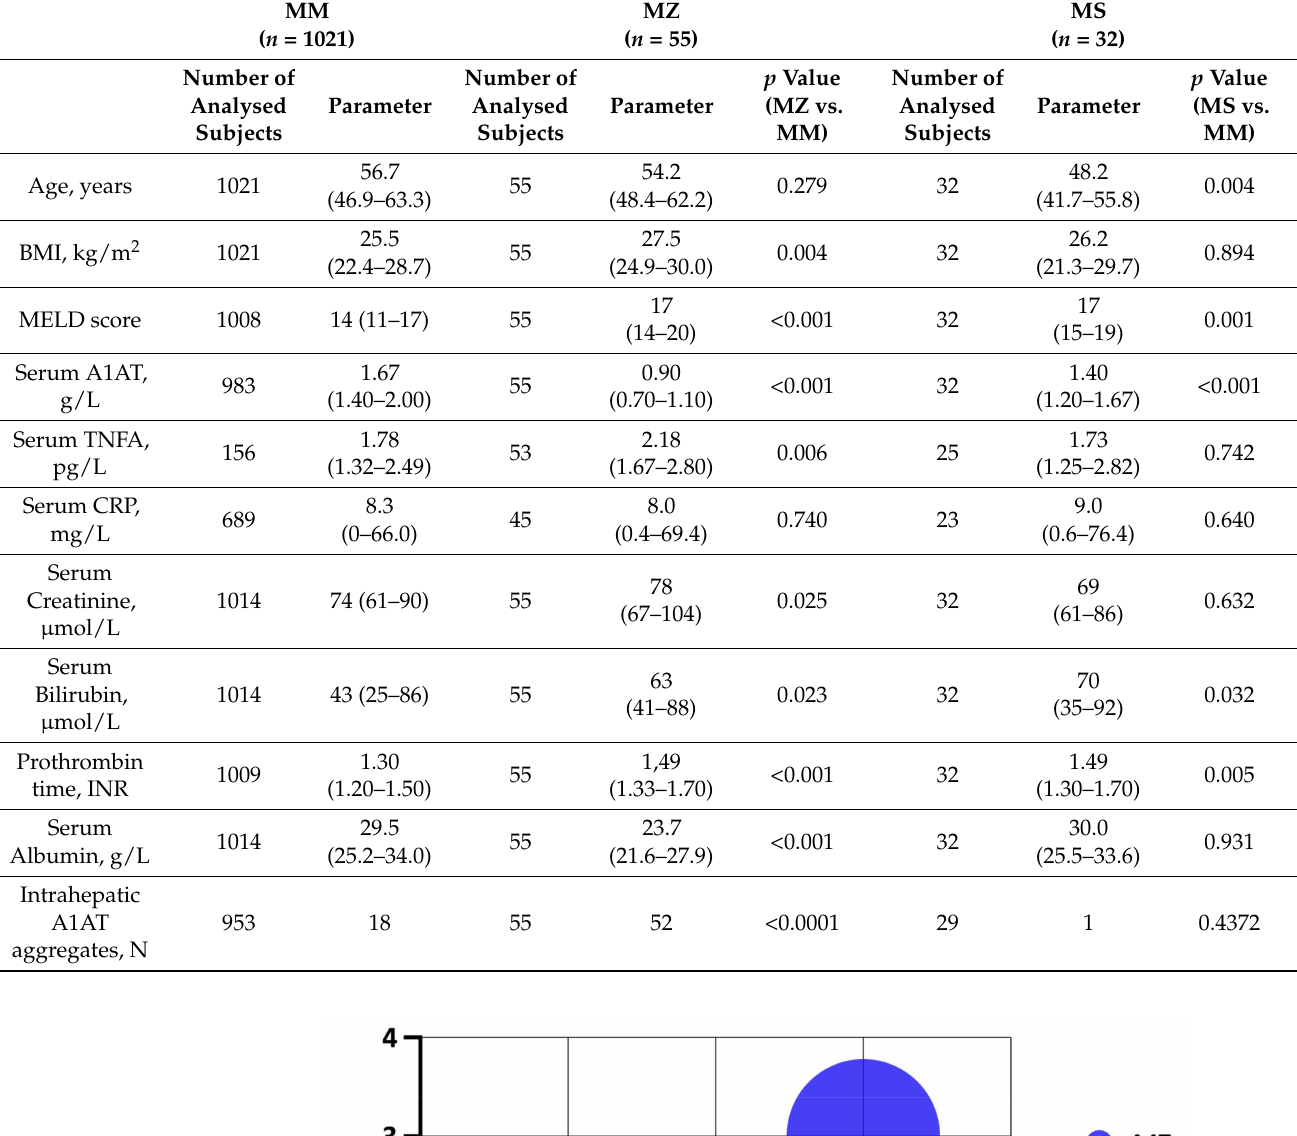
Table 4. Demographic and laboratory characteristics of patients grouped according to SERPINA1 genotypes.